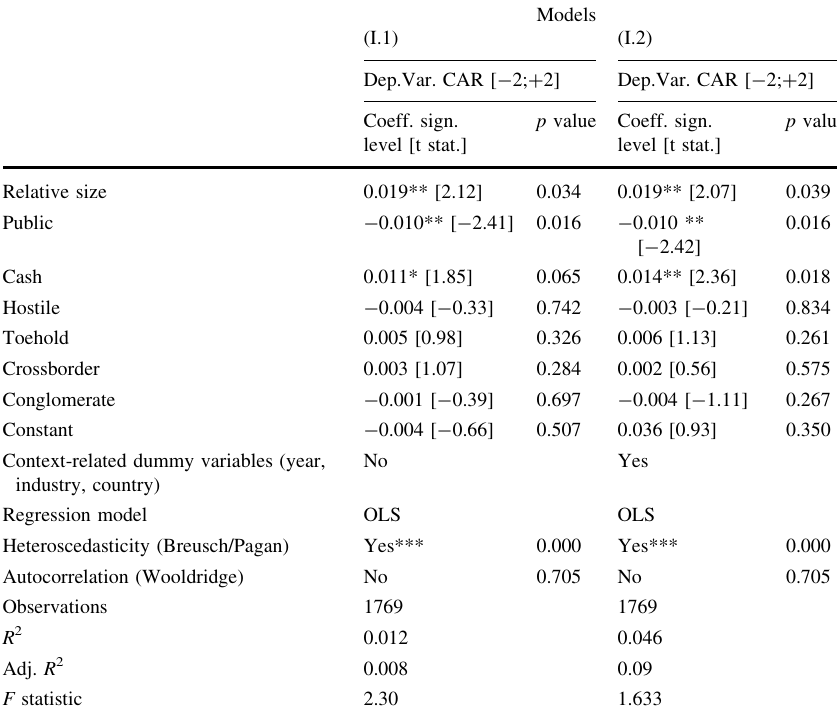
Table 2 Level I—Effect of transaction- and context-related